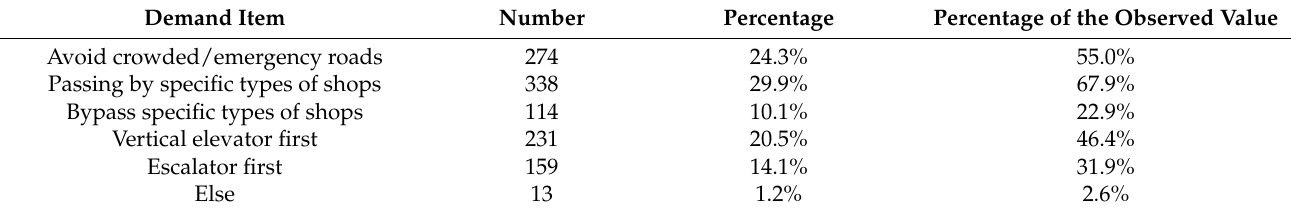
Table 13. Percentage of indoor navigation considerations (multiple choice) in the